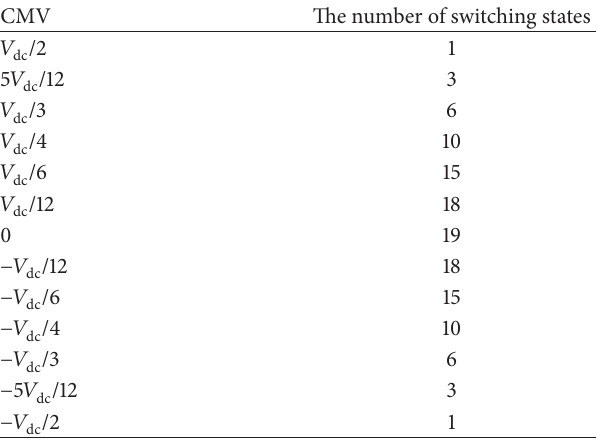
Table 2: CMV and switching states.